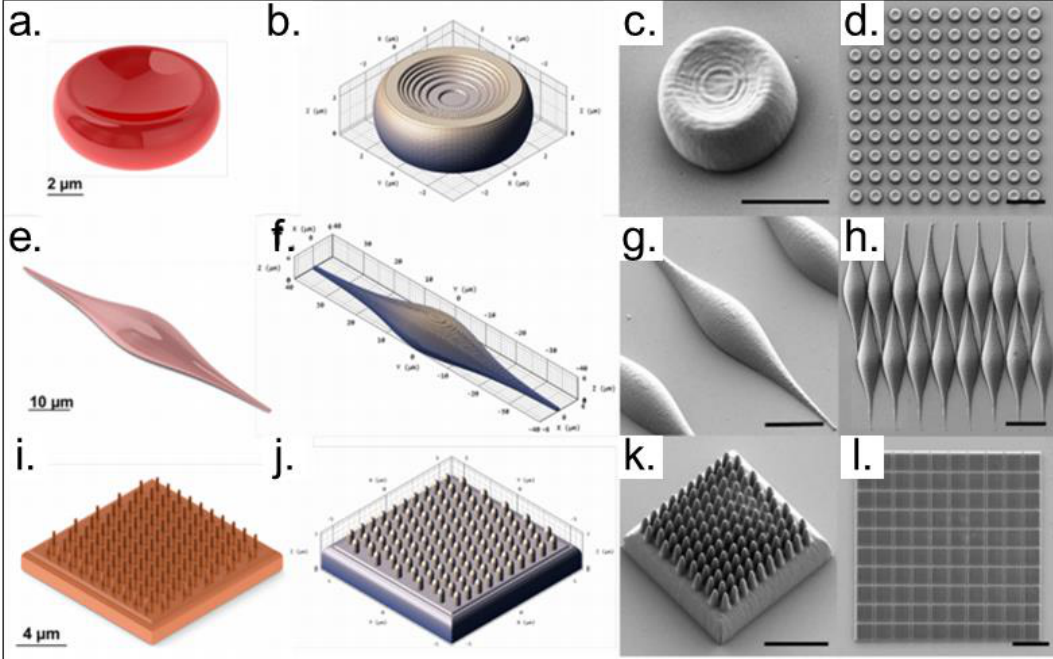
Figure 16. Images showing the designed and fabricated cell scaffolds using additive manufacturing with optimized parameters. ( a – d ) Red blood cell (RBC) model. ( e – h ) Smooth muscle cell (SMC) model. ( i – l ) Ciliated columnar epithelial cell (CEC) model. ( a , e , i )—Rendered images of the 3D designs for a single cell. ( b , f , j )—preview of a single cell generated in the DeScribe software after defining the parameters for the additive manufacturing fabrication process. ( c , g , k )— Scanning electron micrographs of the fabricated individual cells, acquired using a 30 ◦ stage tilt, scale bar is 5 µ m. ( d , h , l )— 120 × 120 µ m 2 cell arrays, scale bar is 25 µ m. Reproduced with permission [152]. Licensed under a Creative Commons Attribution 4.0 International